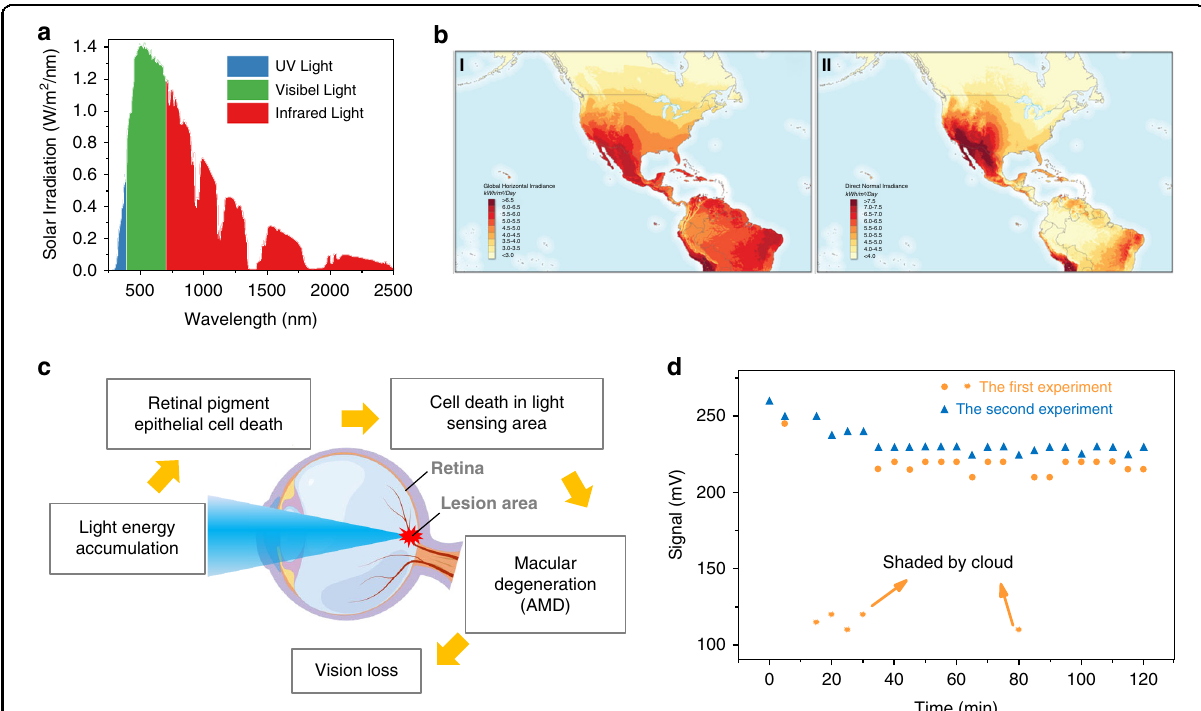
Fig. 3 Characteristics of sunlight and its hazards. a Wavelength distribution of sunlight. Reproduced with permission from ref. 228 . Copyright 2017, Wiley Online Library. b Global horizontal irradiance (I) and direct normal irradiance (II) for the US and Central America. Reproduced with permission from ref. 48 . Copyright 2018, Elsevier. c Possible effects of short-wavelength, high-energy light on vision. d Changes in the detection signal before and after exposure to